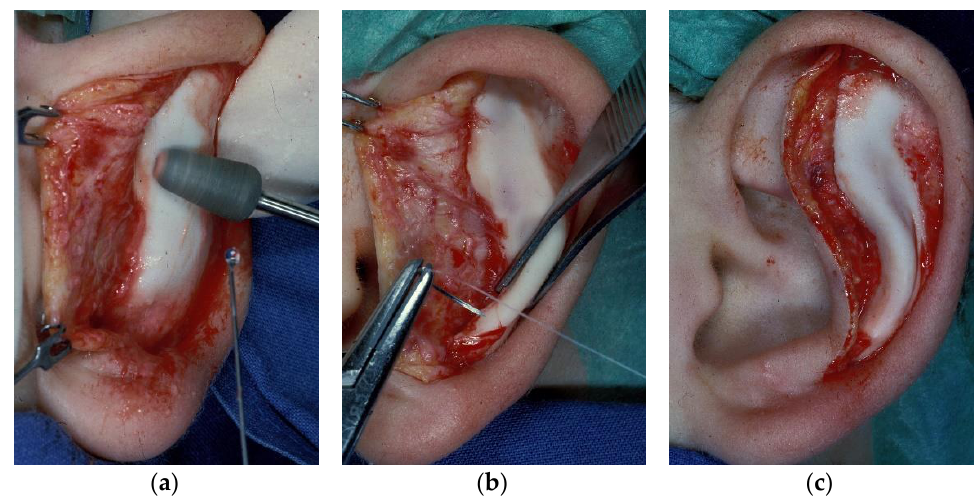
Figure 1. Ventral otoplasty technique. ( a ) Skin incision is shown along the scapha, followed by flap-raising until the area of the anticipated antihelical fold is fully exposed. A diamond grinder is used along the anticipated antihelical fold to abrase and thin out the cartilage. By regular palpation of this area, abrasion is performed until the cartilage shows an adequate thinness for folding. ( b ) U-sutures are placed with knots lying proximal to the concha and away from the helix after cartilage thinning. Two or three knots are placed along the antihelical fold for definite fixation. ( c ) This shows the result after fold fixation. Knots are not seen because sutures are colorless and lie proximal to the conchal area and are disguised by its tissue.